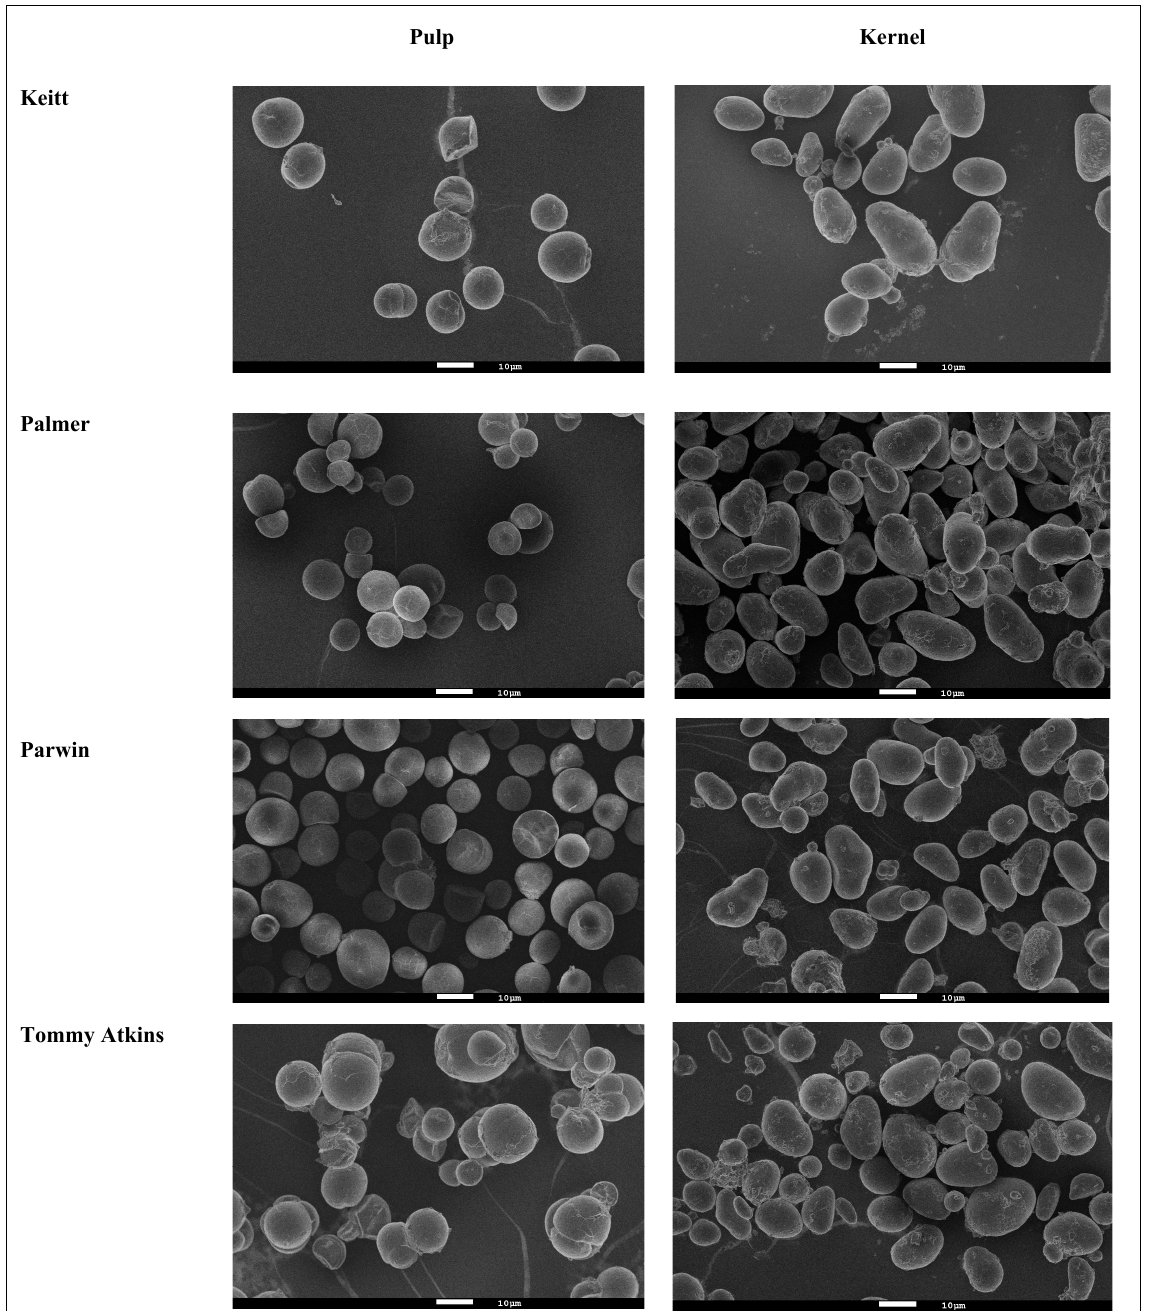
Figure 1. Scanning electron micrographs of mango starches.